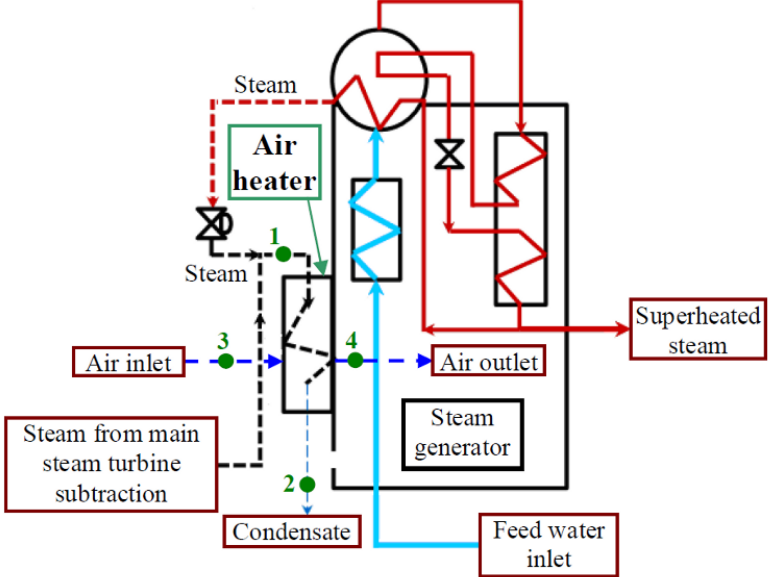
Figure 3. Schematic view of the steam air heater mounted on steam generator with main stream flows.